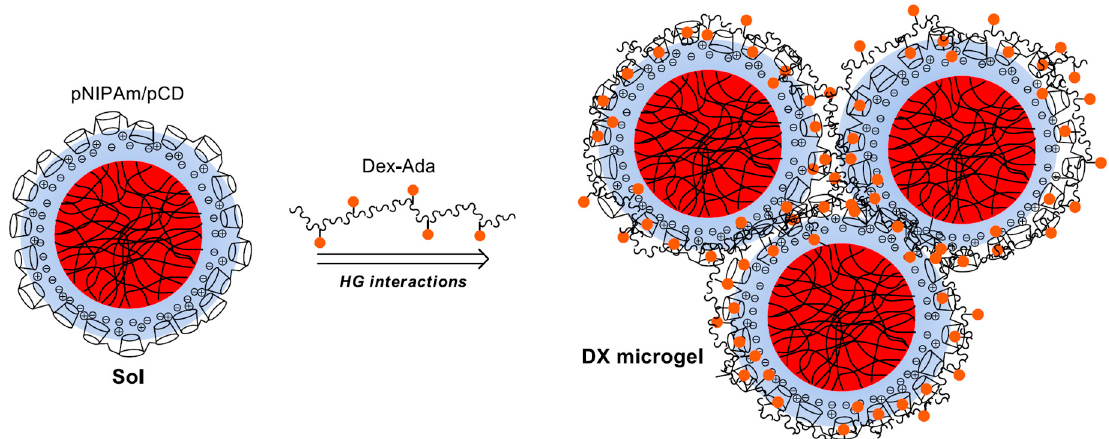
Figure 1. Schematic illustration of the strategy for host–guest-driven crosslinking of pCD - coated pNIPAm core (red)/AAc shell (blue) microgels into a 3D DX microgel network. pNIPAm core (red)/AAc shell (blue) microgels into a 3D DX microgel